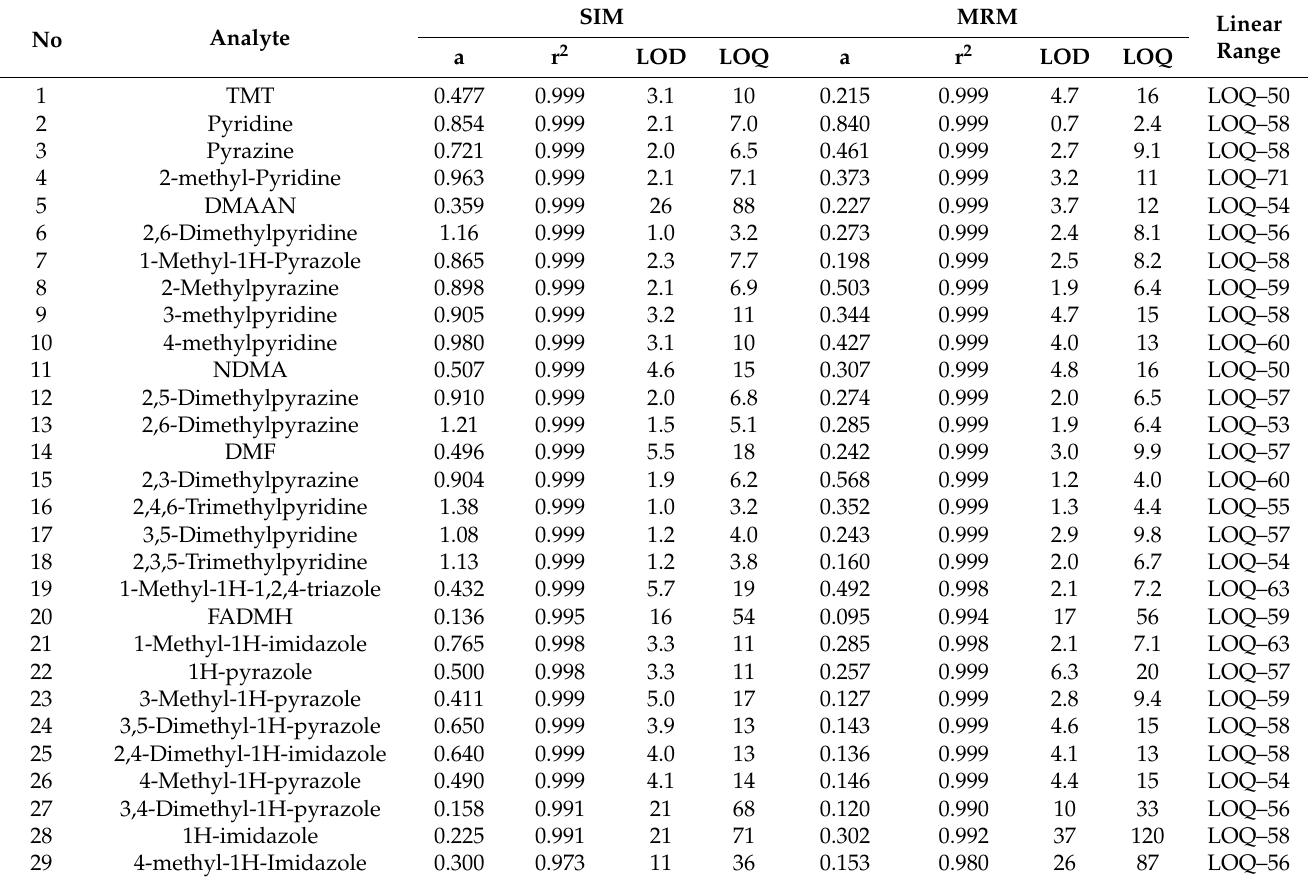
Table 1. The key specifications of the developed AWASP-GC-MS method and parameters of calibration curve (S a /S is = aC a ), linear range, limits of detection, and quantification ( µ g L − 1 ) for SIM and MRM detection